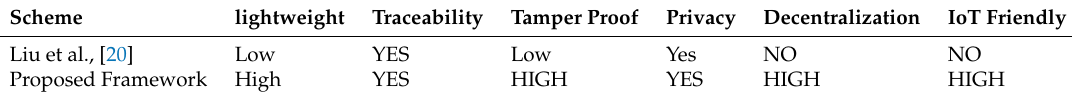
Table 3. Comparison Performance of Proposed Work and